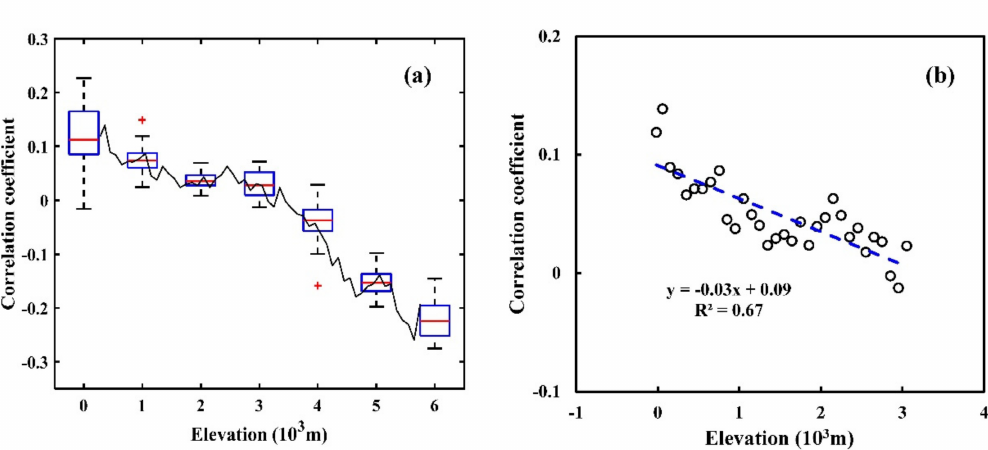
Figure 11. Correlation between winter snowfall and growing season vegetation greenness across the elevation below 6000 m ( a ) and 3000 m ( b ) for the period 1982–2015. The red plus represents the outlier, namely the data point which is greater than q 3 + 1.5 × ( q 3 − q 1 ) or less than q 1 − 1.5 × ( q 3 − q 1 ). q 1 and q 3 are the 25th and 75th percentiles of the sample data,